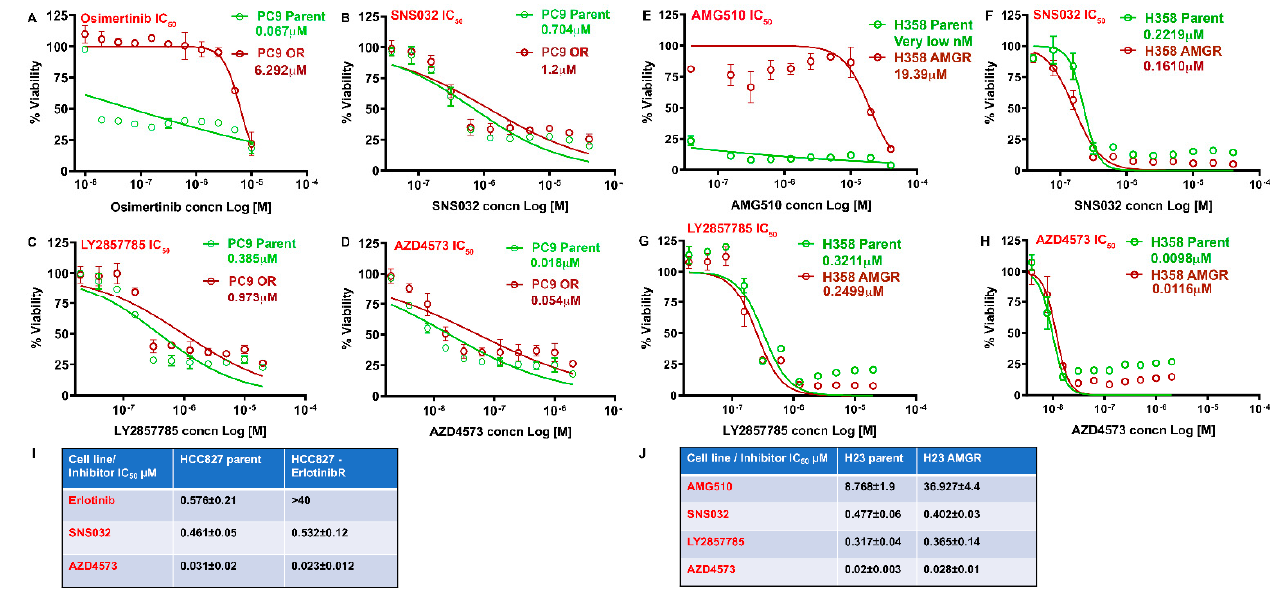
Figure 5. CDK9 inhibitors are effective against Osimertinib-resistant and AMG510-insensitive lung cancer cells: IC 50 analysis was conducted, on Osimertinib-sensitive and-resistant PC9 cells with varying concentrations of Osimertinib ( A ), or the CDK9 inhibitors SNS032 ( B ), LY2857785 ( C ), or AZD4573 ( D ), using the GraphPad Prism software. ( E – H ) IC 50 curve for AMG510 and CDK9 inhibitors on AMG-sensitive and -insensitive H358 cells treated with ~ AMG510 ( E ), SNS032 ( F ), LY2857785 ( G ), or AZD4573 ( H ). ( I ) Chart shows the IC 50 values (mean ± SD) for SNS032 and AZD4573 for HCC827 parent and HCC827 erlotinib resistant cells. ( J ) Chart shows the IC50 values (mean ± SD) for SNS032, LY2857785 and AZD4573 on AMG-sensitive and -insensitive H23 cells from three independent experiments conducted in duplicates.